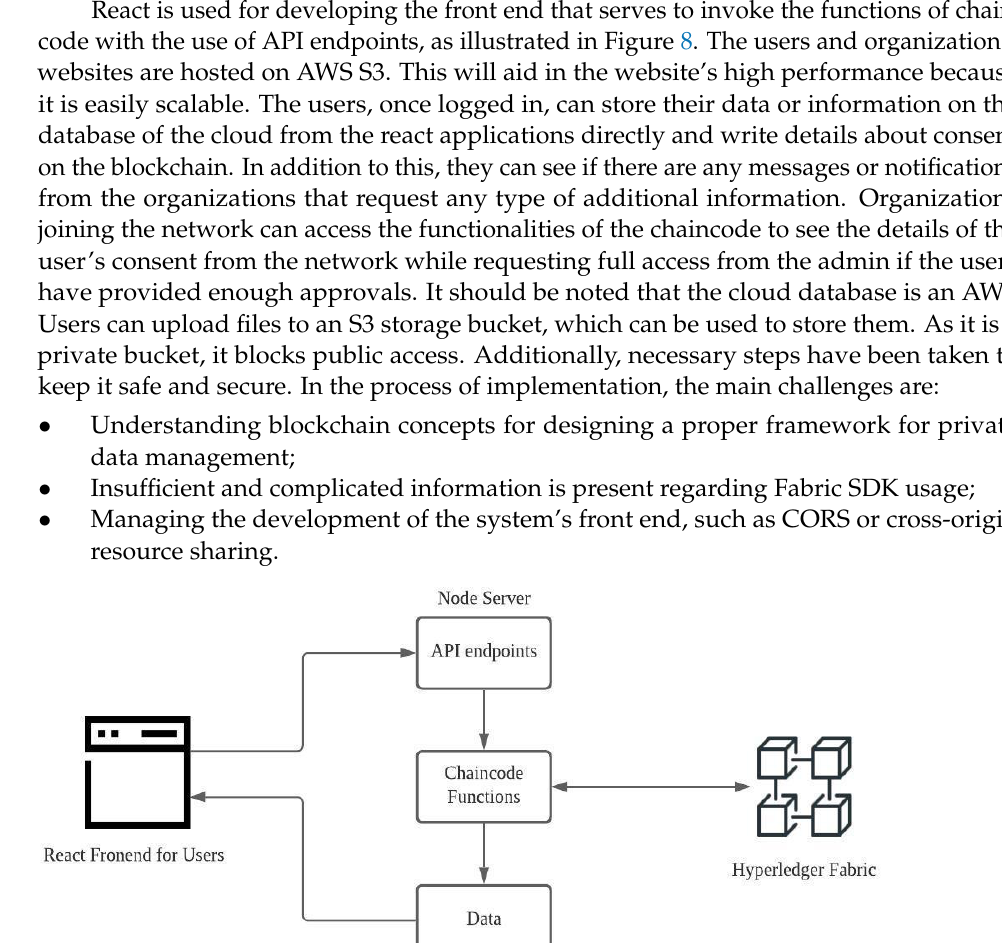
Figure 7. Setup of Fabric on virtual machines.